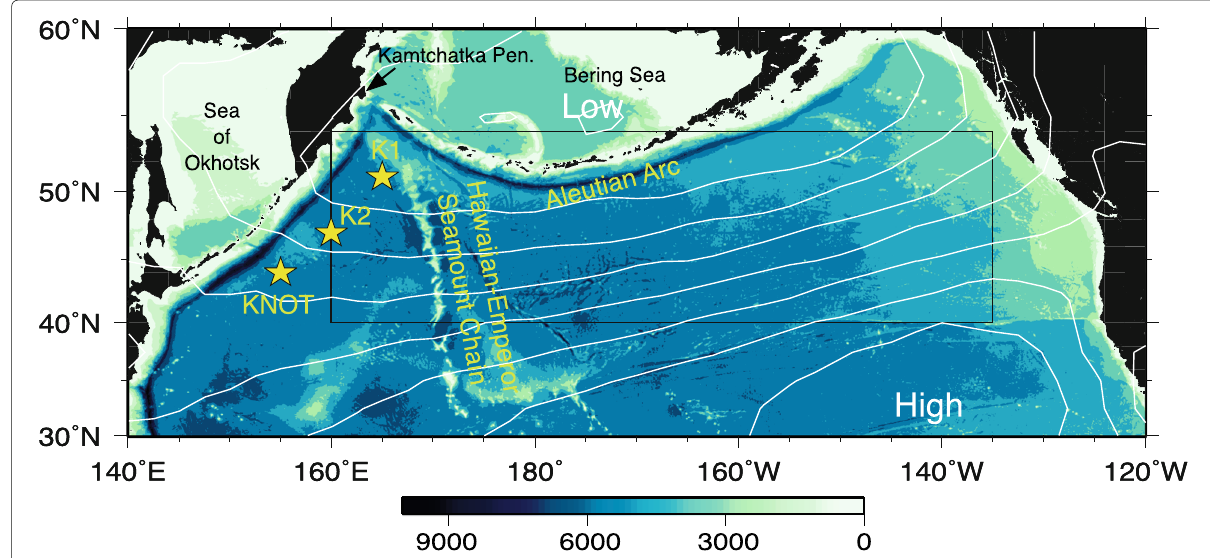
Fig. 3 Map of the North Pacific including the bottom topography. Bottom topography is based on ETOPO1 data. The wind stress data in the region enclosed by a square were used for the calculations of SSH at stations K1, K2, and KNOT. NCEP/NCAR sea-level pressure (hPa) averaged during the study period is denoted by white contours with intervals of